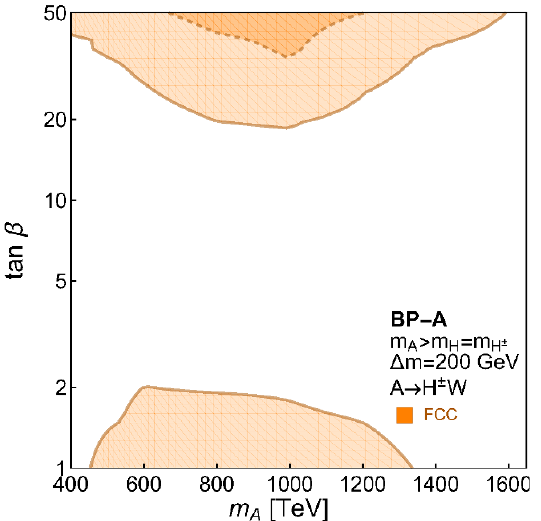
Figure 5 . Reach for the exotic decay channel A ! H (cid:6) W (cid:7) ! t h bl(cid:23) for BP-A at a 100 TeV pp collider in the tan (cid:12) vs. m A plane for m A (cid:0) m = 200 GeV. The solid and dashed line correspond H (cid:6) to the exclusion and discovery reach,